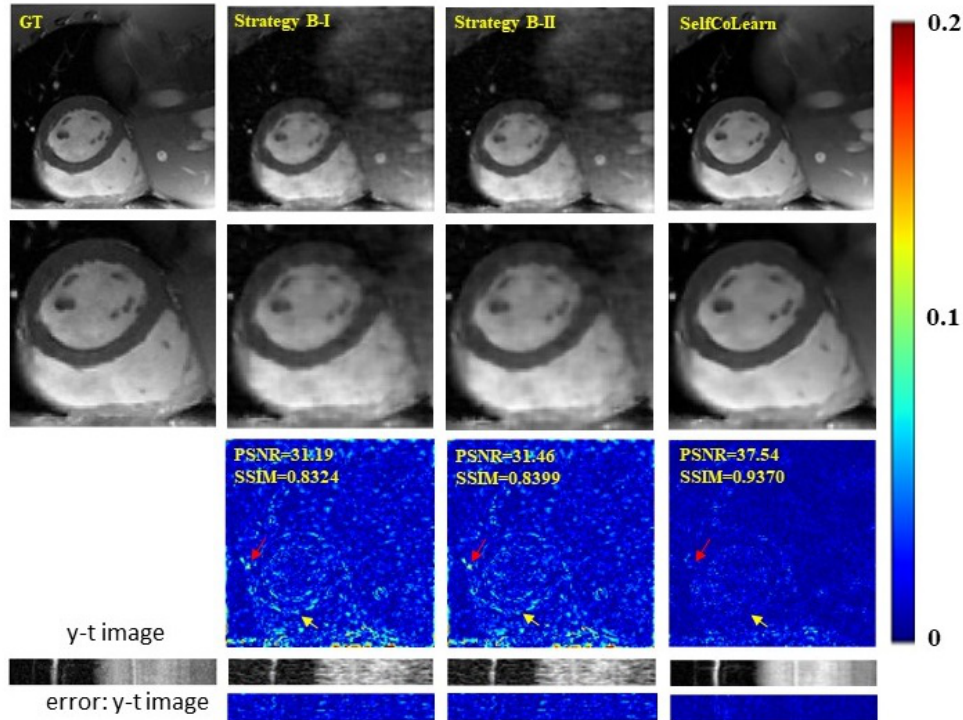
Figure 6. Ablation studies utilizing different training strategies at 8-fold acceleration. The first row shows the ground truth (fully sampled image), and the reconstruction images of strategy B-I, strategy B-II, and proposed SelfCoLearn (10th frame). The second row shows their enlarged images in the heart regions. The third row plots the error images of respective methods. The last two rows show y-t images (the 40th slice along the dimensions of y and t) and the corresponding error images.